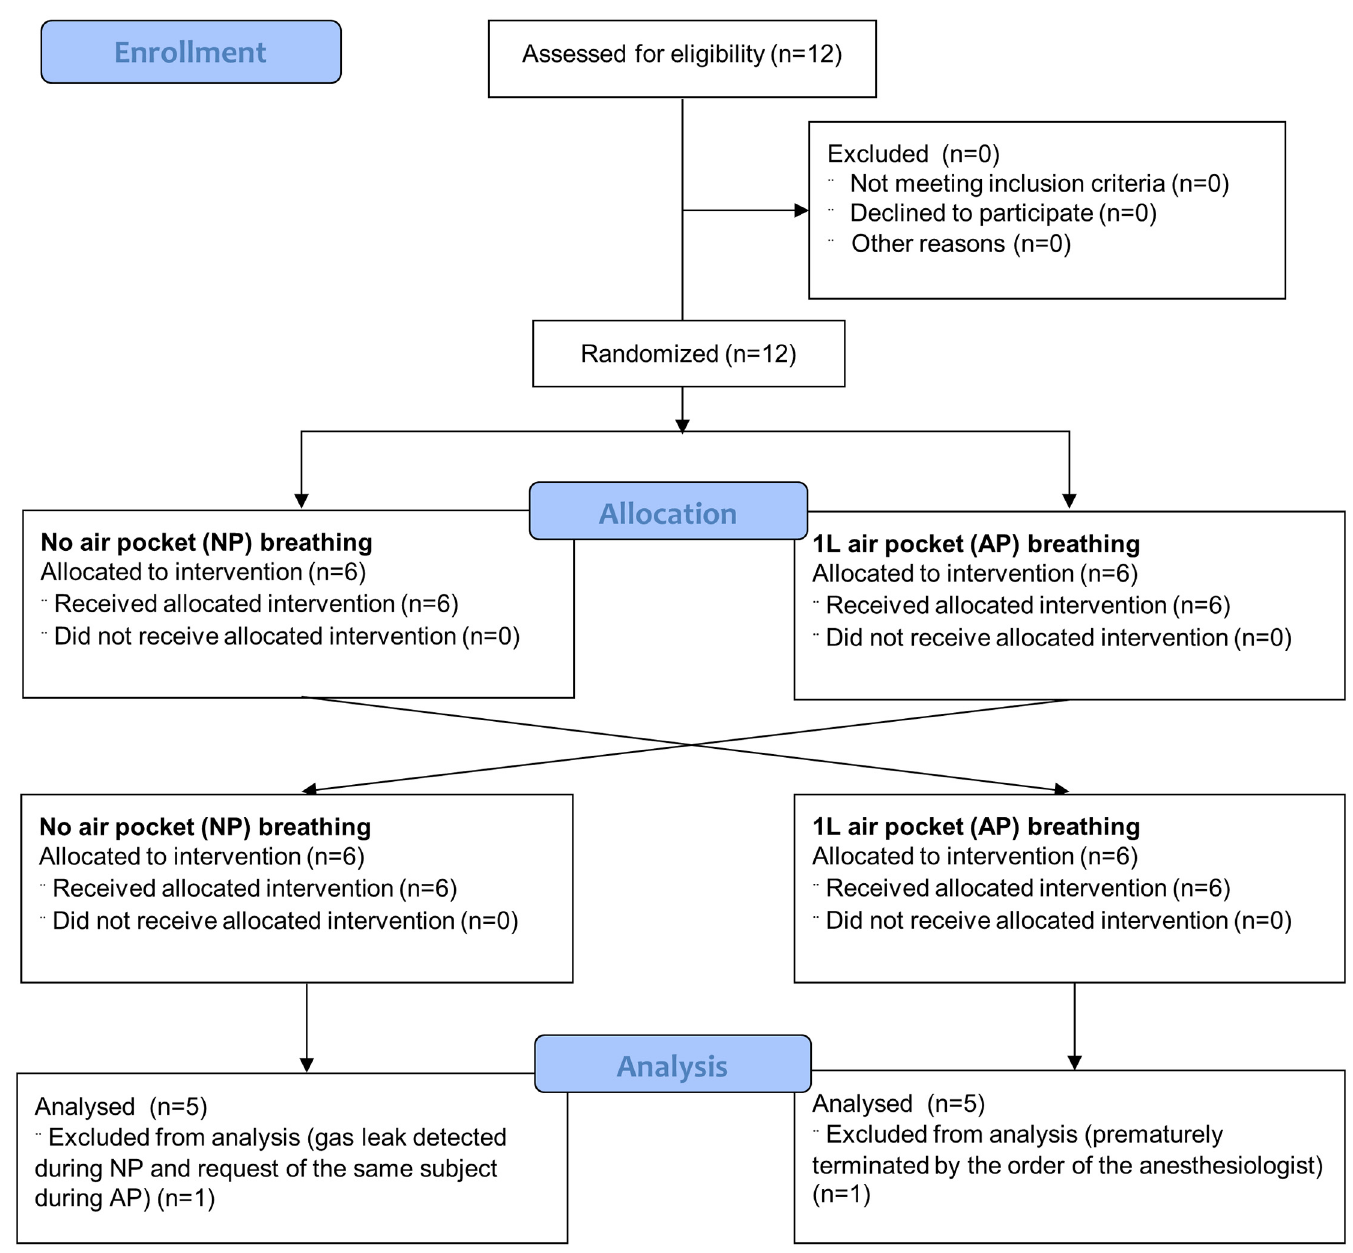
Fig 1. Flow diagram of the study with enrollment, allocation and analysis of the